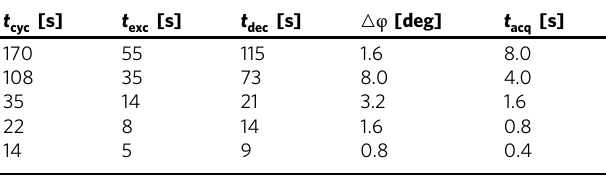
Table 1 Pump-probe sequences tested in this